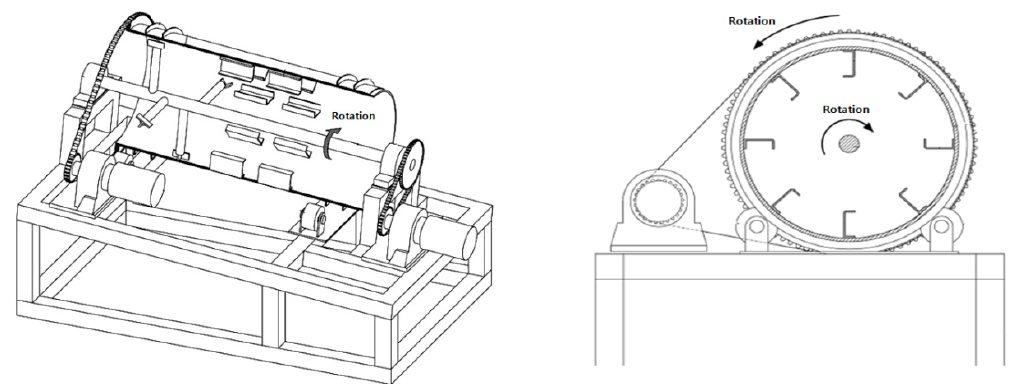
Figure 7. Perspective schematics of the aggregate mixing equipment and mixing method.